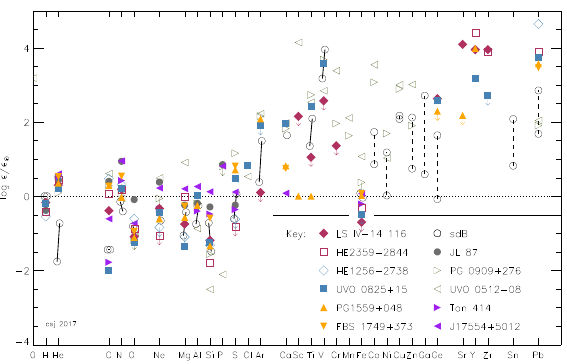
Figure 5. Surface abundances of super metal-rich hot subdwarfs, including the pulsating stars LS IV−14 ∘ 116 and UVO 0825+15, the iron-group CP stars UVO0512–08 and PG0909+276 (Wild and Jeffery 2017), and the new lead-rich discoveries. Abundances are shown relative to solar values (dotted line). Mean abundances and ranges for normal subdwarfs are also shown. The latter are shown by connected open circles as (i) Z ≤ 26 (solid lines): the average abundances for cool and warm sdBs (Geier 2013) and (ii) Z ≥ 27 (broken lines): the range of abundances measured for five normal sdBs from UV spectroscopy (O’Toole and Heber 2006).